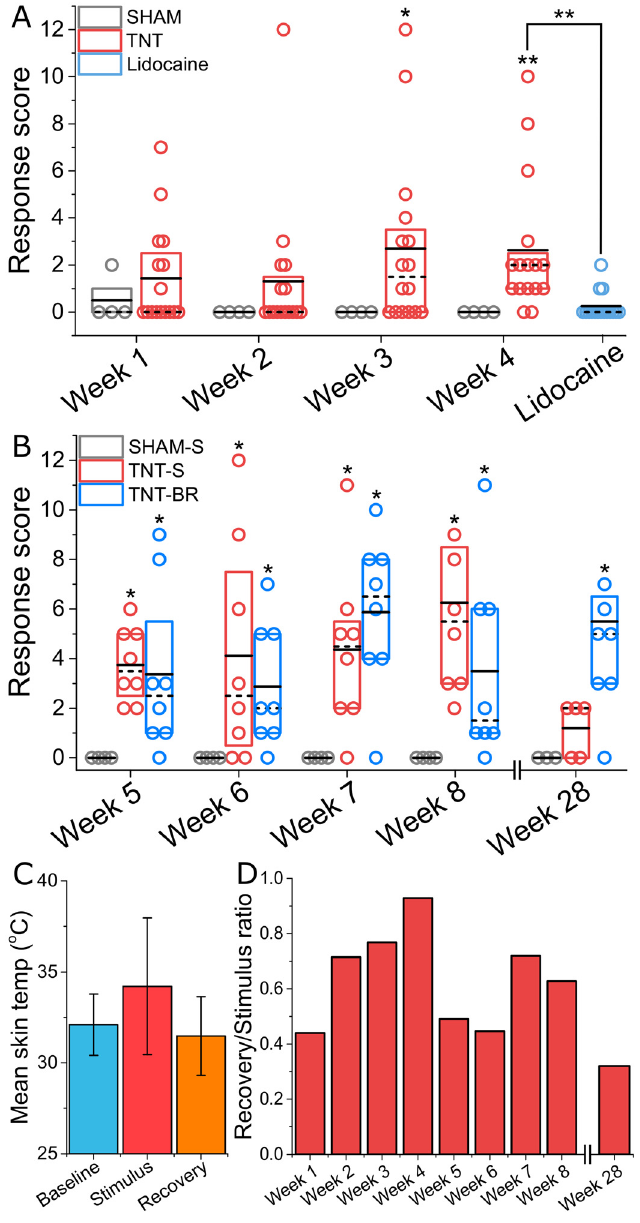
Fig 2. Radio-frequency electromagnetic field (RF EMF) stimulation elicits post-neurotomy pain. (A) Hollow circles indicate the summed response score for each animal for both TNT (red) and SHAM (grey) groups. Only one behavioral pain response was observed in the SHAM group over all 10 experimental trials. Statistically significant mean response scores (solid black line) were observed between TNT and SHAM groups beginning in week 2 and continuing through week 8. Lidocaine was found to be a successful moderator of RF EMF-induced neuroma pain. Dashed black lines indicate population median. (B) Following bulb resection surgery, significant RF EMF-induced neuroma pain persisted from week 5 until week 28. For statistical comparisons, a two-tailed Mann-Whitney test was used ( * p < 0.05, ** p < 0.01). (C) RF EMF exposure induces mean skin temperature increase. A mean skin temperature increase of 2.2°C was observed following 10 minutes of RF EMF exposure. (D) Recovery/Stimulus behavioral response ratios for all time